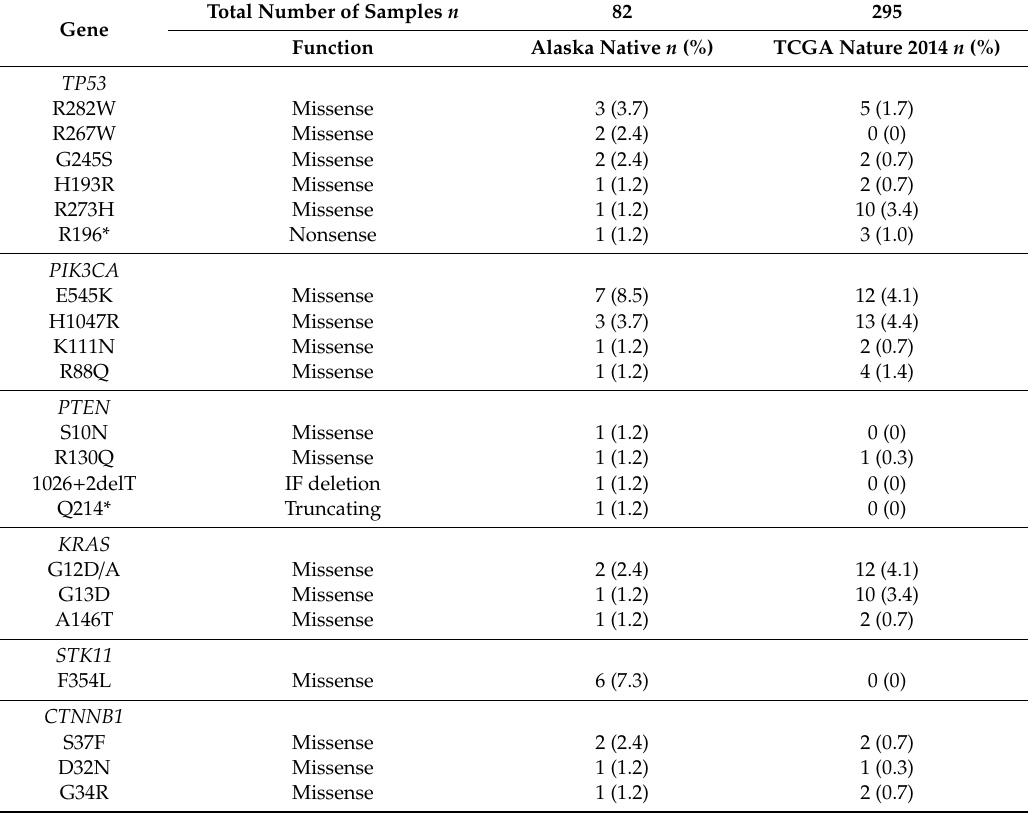
Table 3. Frequency of most prevalent single nucleotide variant (SNV) gene